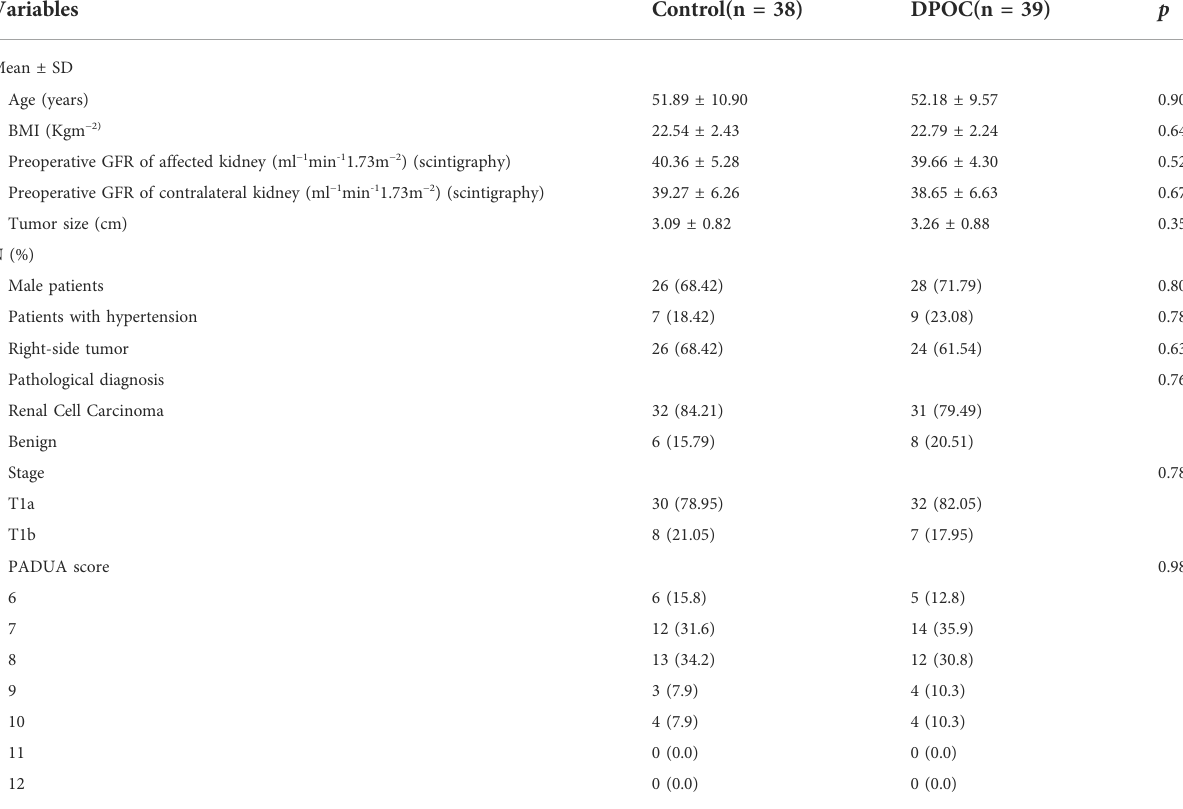
TABLE 1 Baseline patient demographics and tumor characteristics.